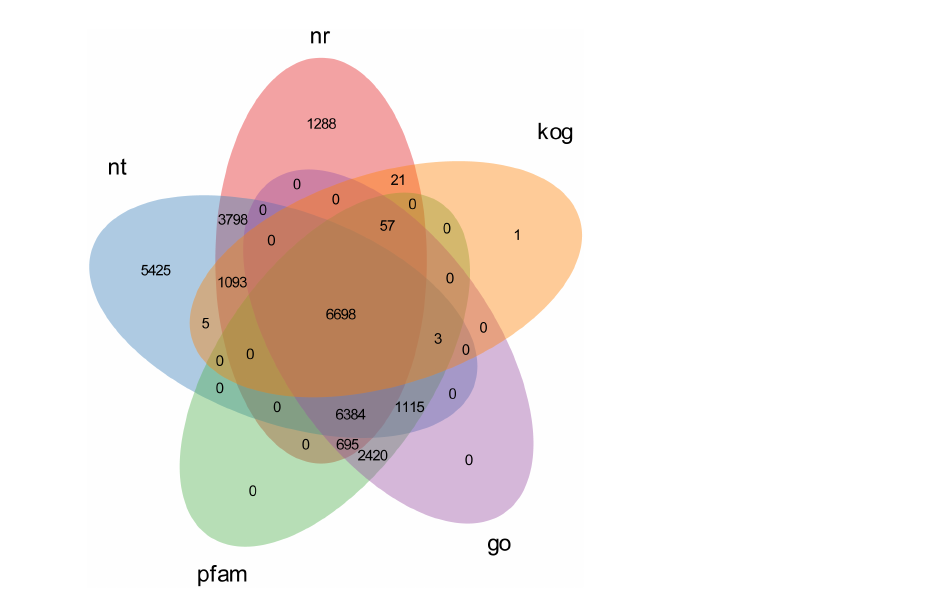
FIGURE 4 Venn diagram of overlap of the seven databases.